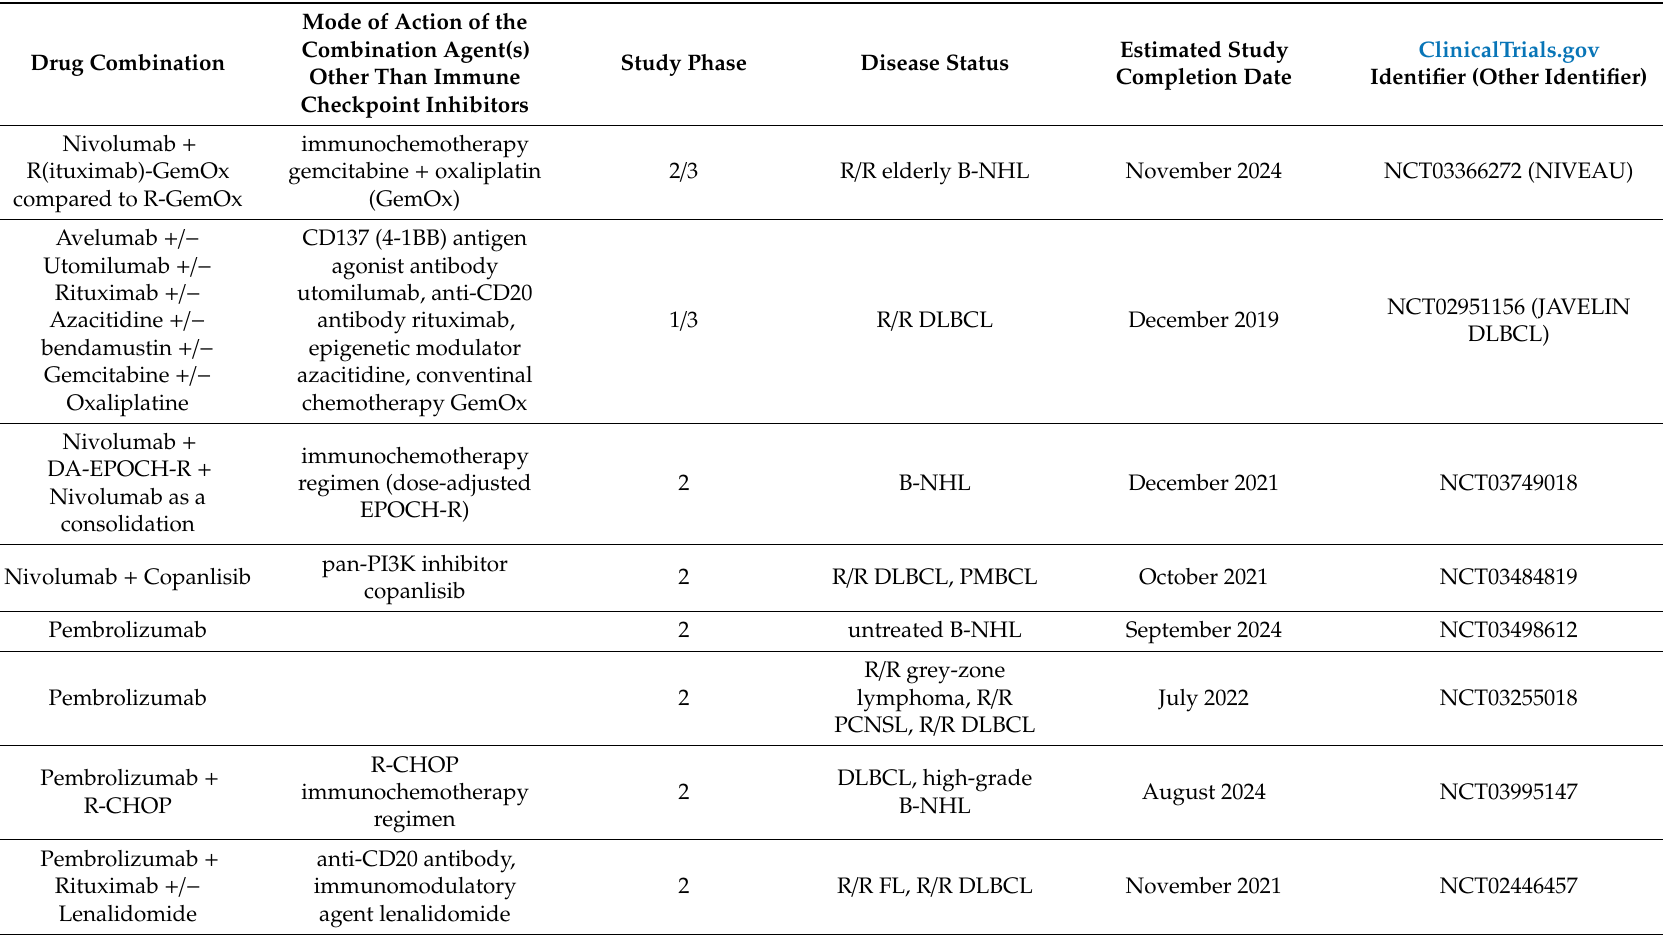
Table 6. Selected clinical trials that incorporate immune checkpoint inhibitors in experimental therapy of